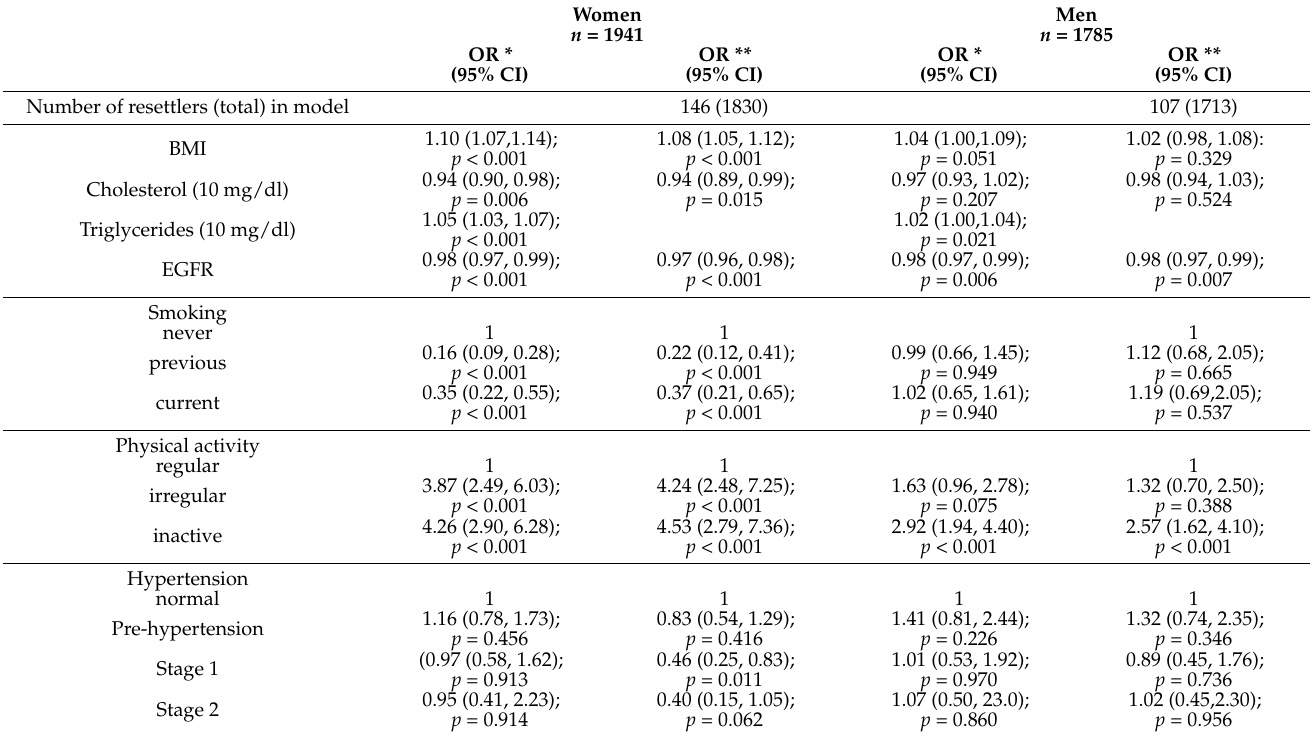
Table 2. Univariable and multivariable logistic regression analysis to identify the differences in the risk factors for cardiovascular diseases between resettlers and native